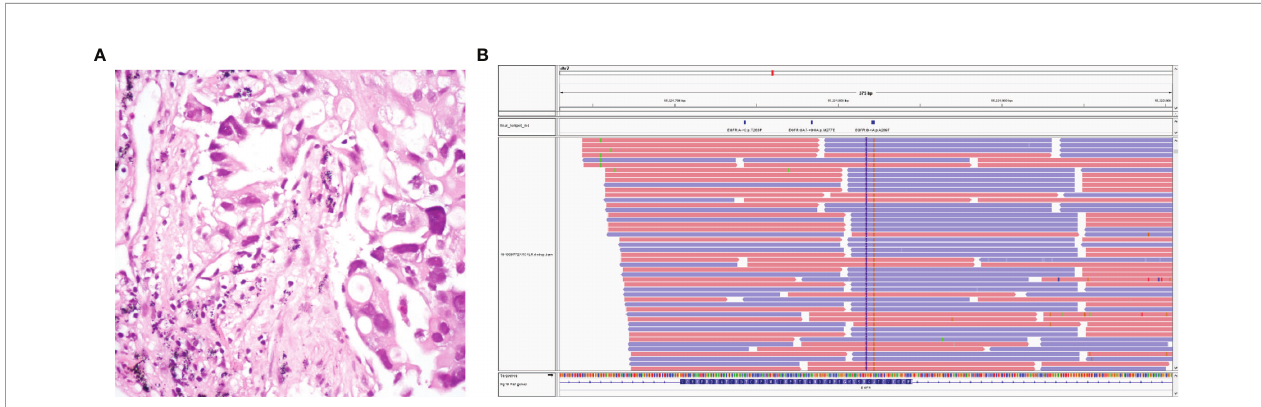
FIGURE 1 | The patient ’ s pathology revealed lung adenocarcinoma (A) . Next-generation sequencing data of circulating tumor DNA indicated two somatic mutations: EGFR p.A289G (c.866C>G) and EGFR p.F287_G288insHA (c.861_862 ins CACGCA) (B)